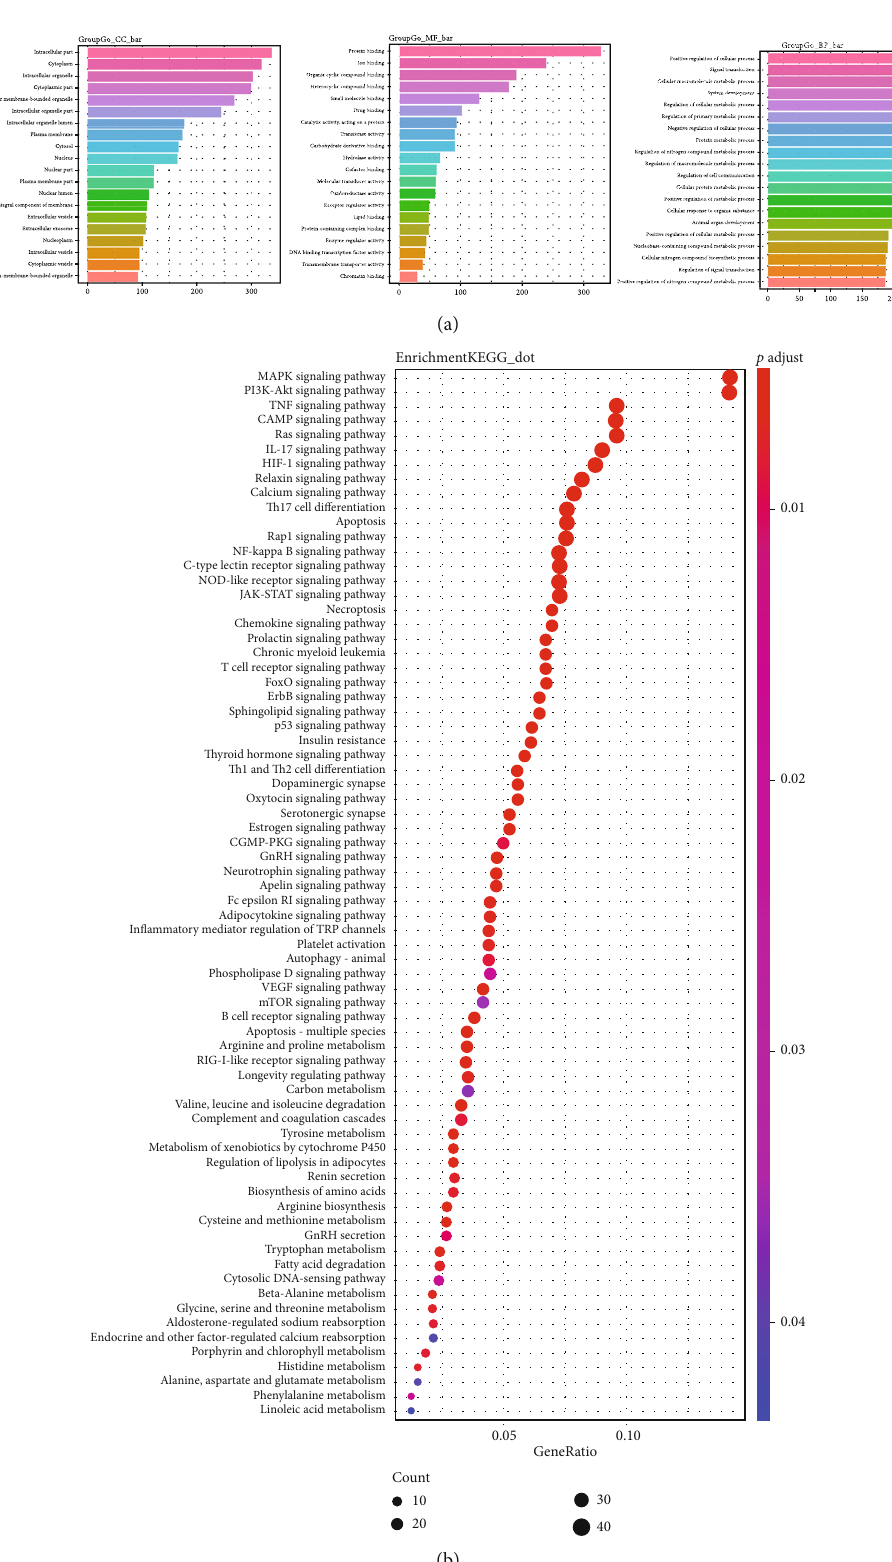
Figure 4: Enrichment analysis. (a) groupGO function for go ontology of 376 targets. The horizontal axis describes the number of genes and the vertical axis describes the GO terms. (b) enrichKEGG function for KEGG pathway enrichment analysis of 345 targets. The horizontal axis denotes generatio, and the vertical axis represents KEGG pathway terms. The size of the spot indicates the gene numbers enriched in each pathway and color indicates FDR